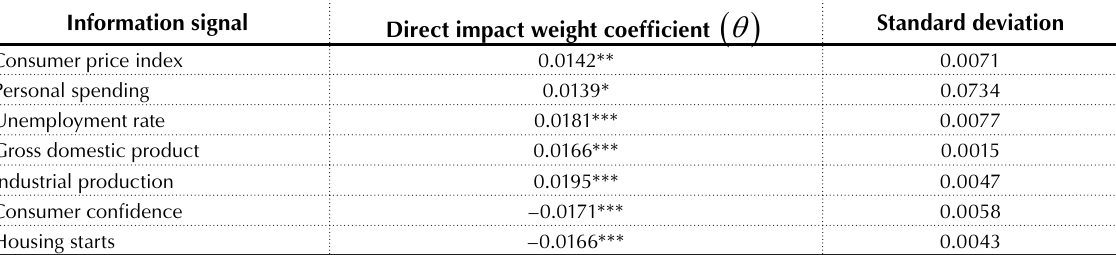
Table 11. The influence of the component of “surprise” on non-monetary information signals of the USA on the volatility of stock prices of enterprises of Ukraine in the economic sector